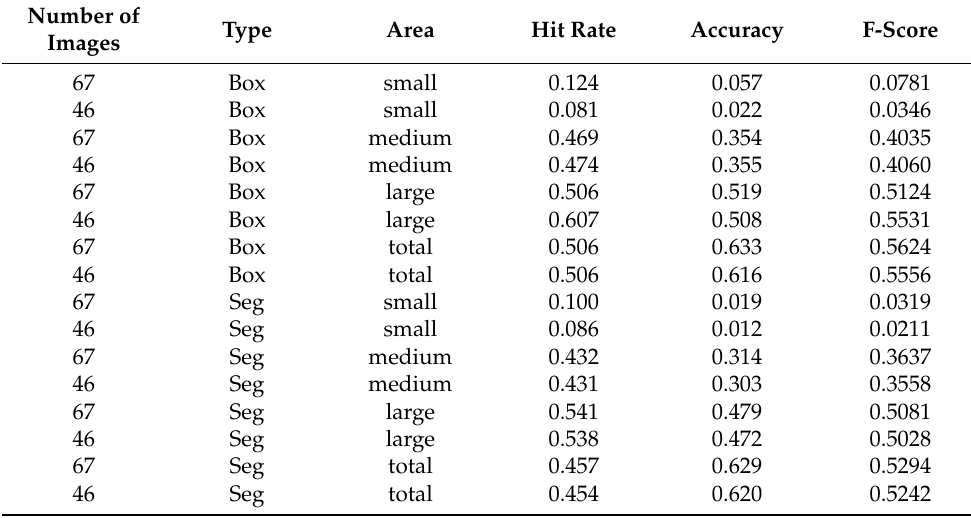
Table 3. Evaluation of Mask R-CNN for quality